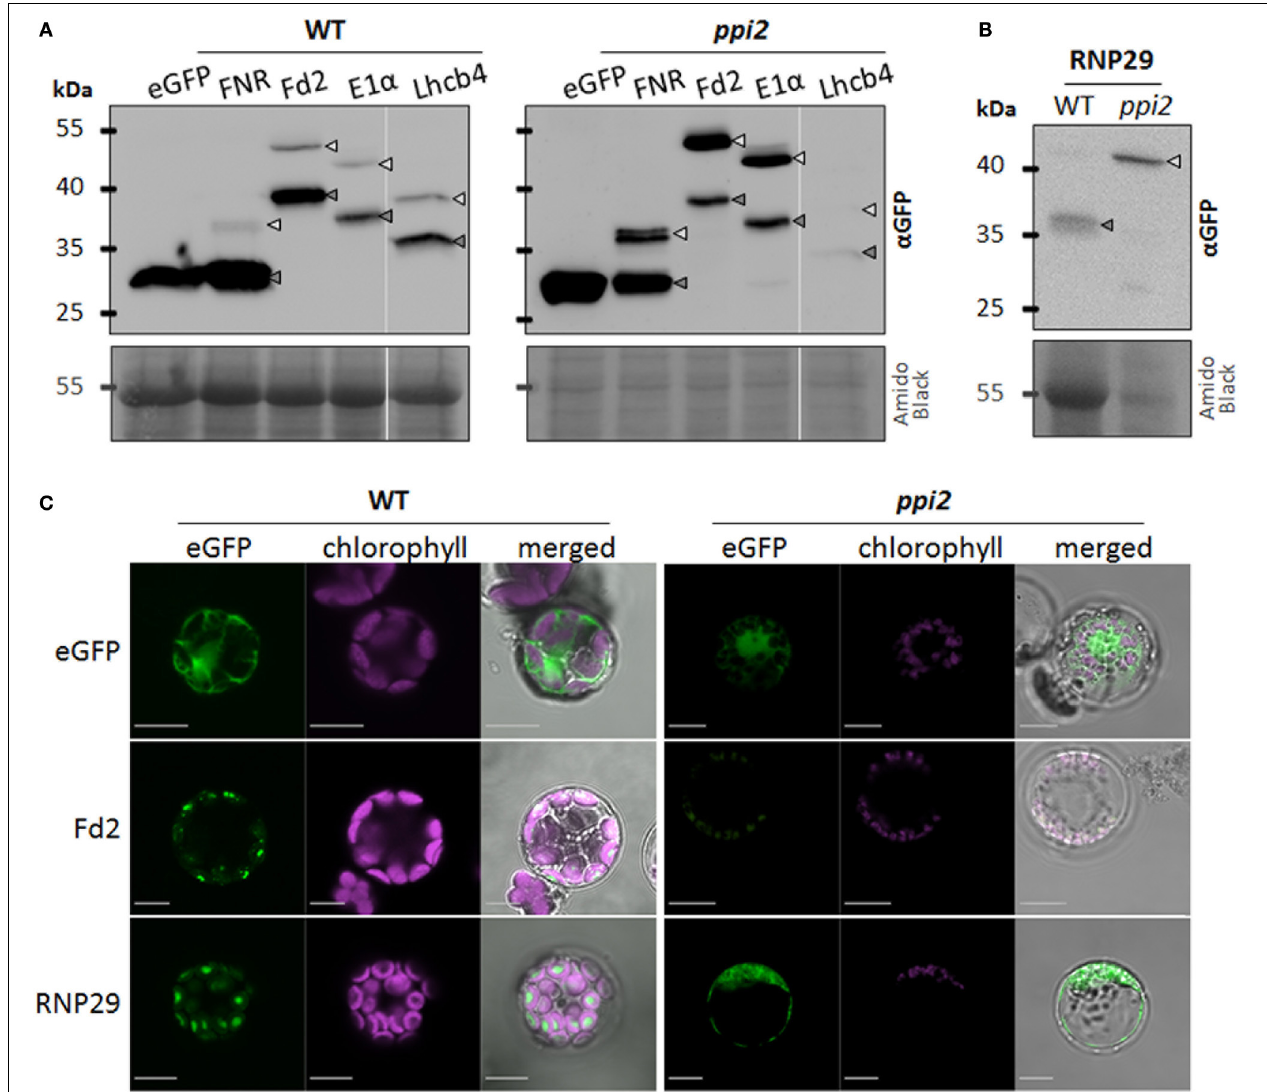
FIGURE 1 | In vivo import of eGFP fusion proteins in the TOC159 deficient mutant ppi2 and in wild type. (A) And (B) Western blot analysis of wild type (WT) and ppi2 protoplasts transiently expressing eGFP or the indicated eGFP fusion protein using an anti-GFP antibody; arrows indicate positions of